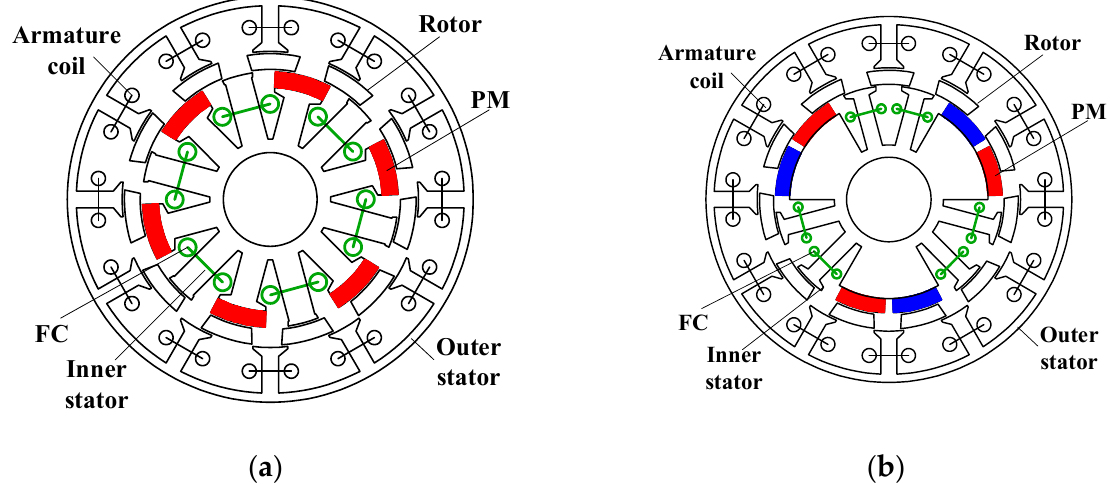
Figure 12. Cross sections of a pair of series and parallel PS HE machines. ( a ) Series HE [57]. ( b ) Parallel HE [58].